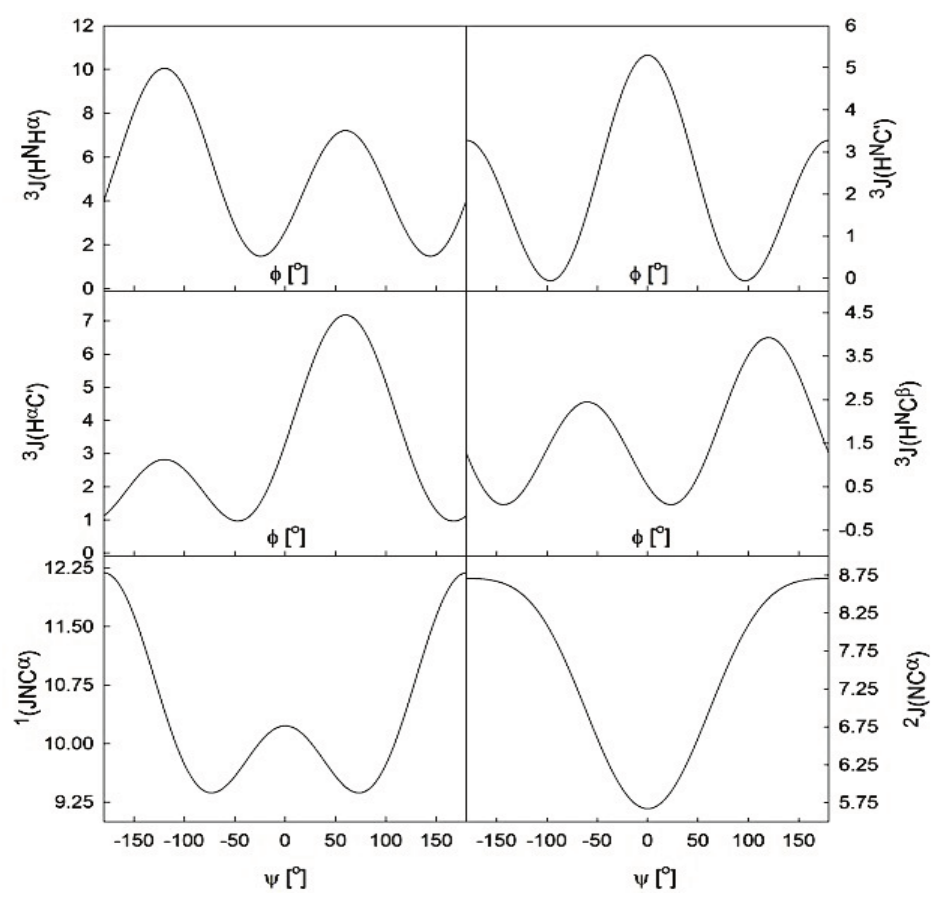
Figure 7. Graphical representation of six Karplus relationships [111,112] of six J-coupling constants which depend differently on the dihedral angles (cid:10) ( upper and middle panels ) and (cid:5) ( bottom panels